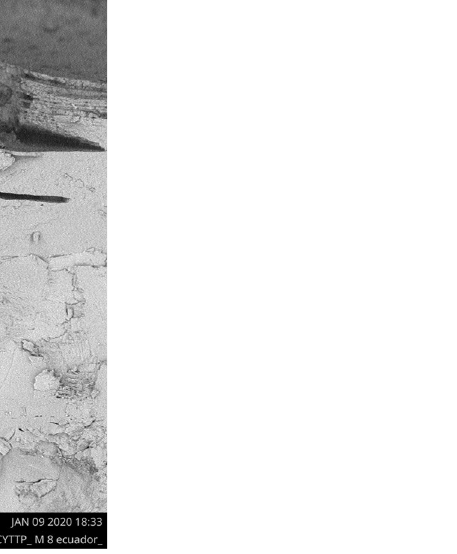
Figure 5. Detail of multiplex intracascaral